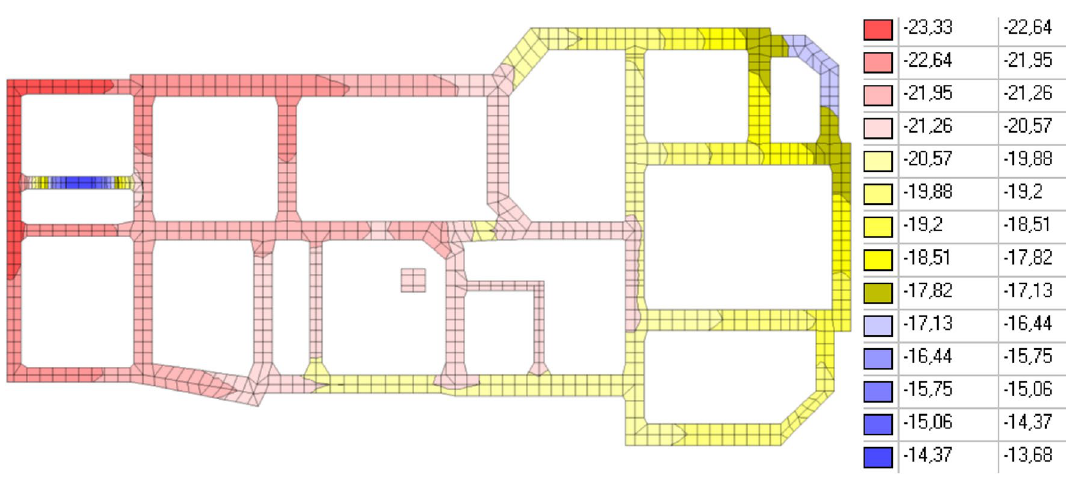
Figure 5. Soil resistance, t/m 2